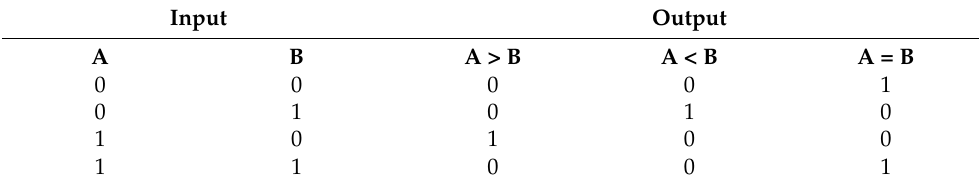
Table 1. Truth table of one-bit comparator.